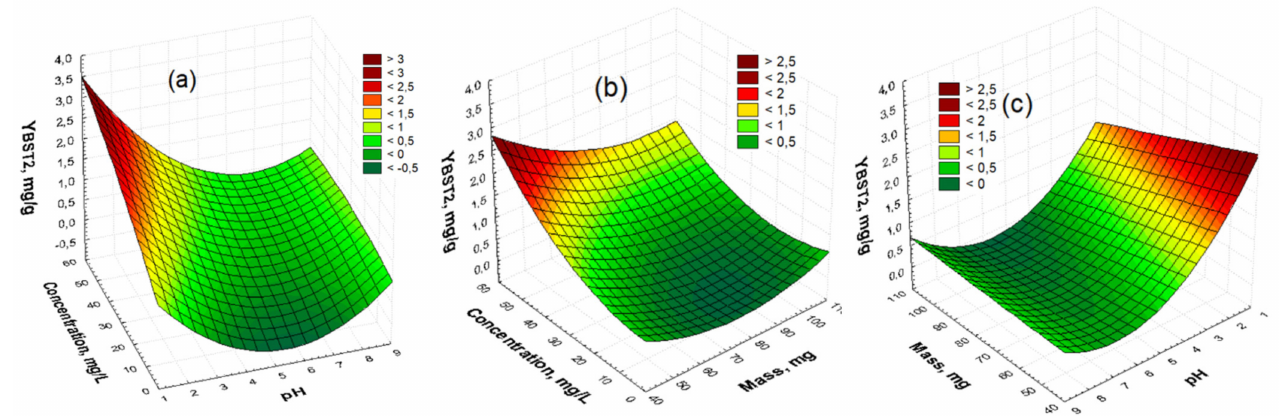
Figure 6. Surface response for the amount of IC adsorbed by the urea-treated (treatment 2) bean pod biomass BST2 as a function of concentration and pH effects ( a ), concentration and mass effects ( b ), pH and mass effects ( c ).